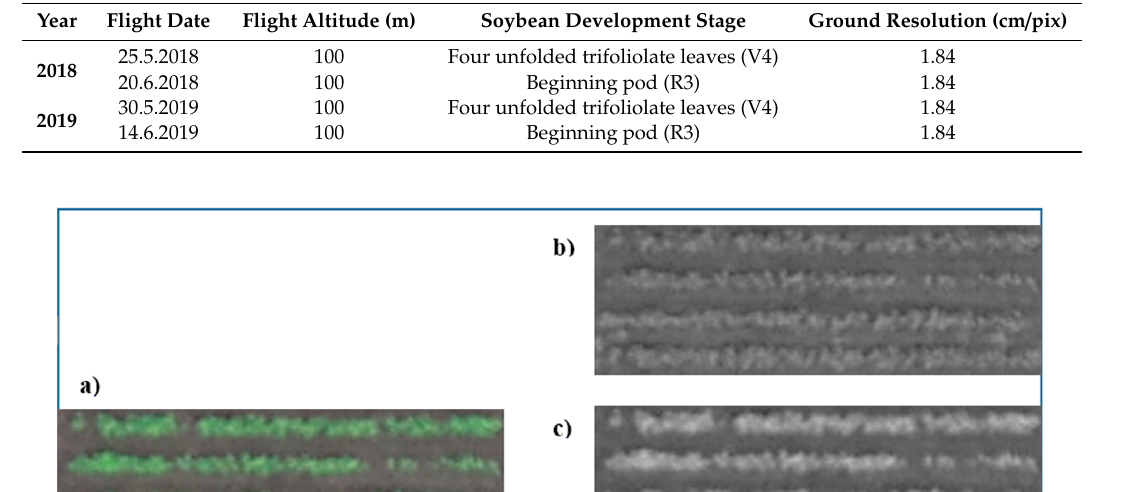
4 of 11 Figure 1. Plot images of soybean in the V4 phase: ( a ) four unfolded trifoliolate leaves and the ( b ) R3 phase—beginning pod; images were taken with the UAV (Unmanned Aerial Vehicle) in 2018 . In both trial years, photos were taken on a sunny day, at a wind speed equal to or less than 10 m/s, and between 10:00 and 14:00; more details about the UAV photo acquisition are given in Table